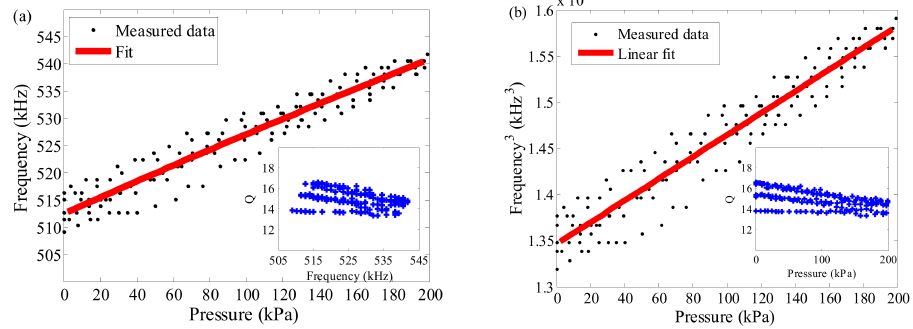
Figure 6. ( a ) Resonance frequency f verse pressure. Inset: Q factor verse f ; and ( b ) f 3 verse pressure. Inset: Q factor verse